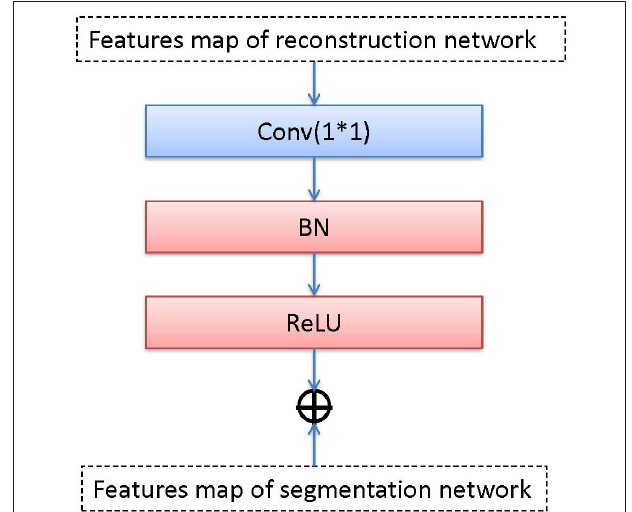
FIGURE 4 | Detailed pipeline of transter